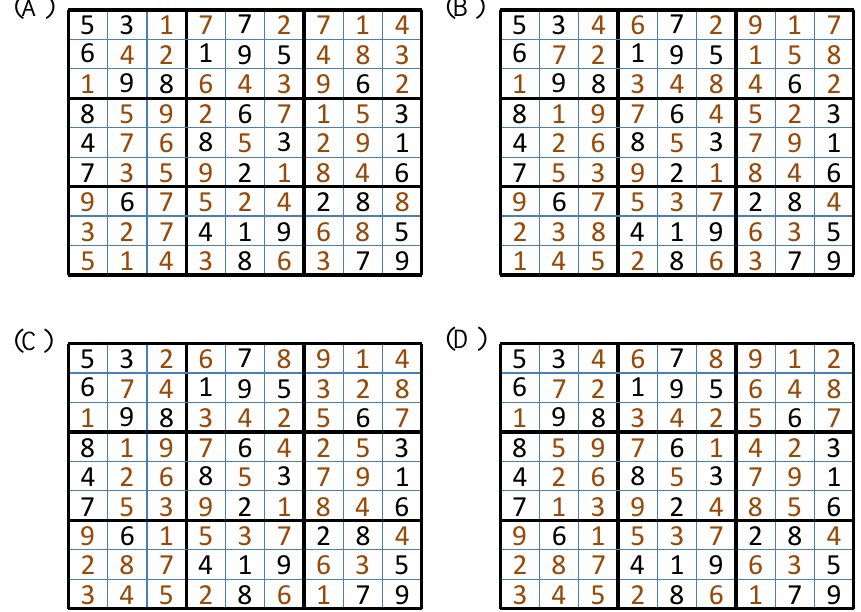
Fig. 3. The daily sudoku: (A) initial solution, and (B) final solution. The black numbers were given, whereas the solution numbers are marked in red.